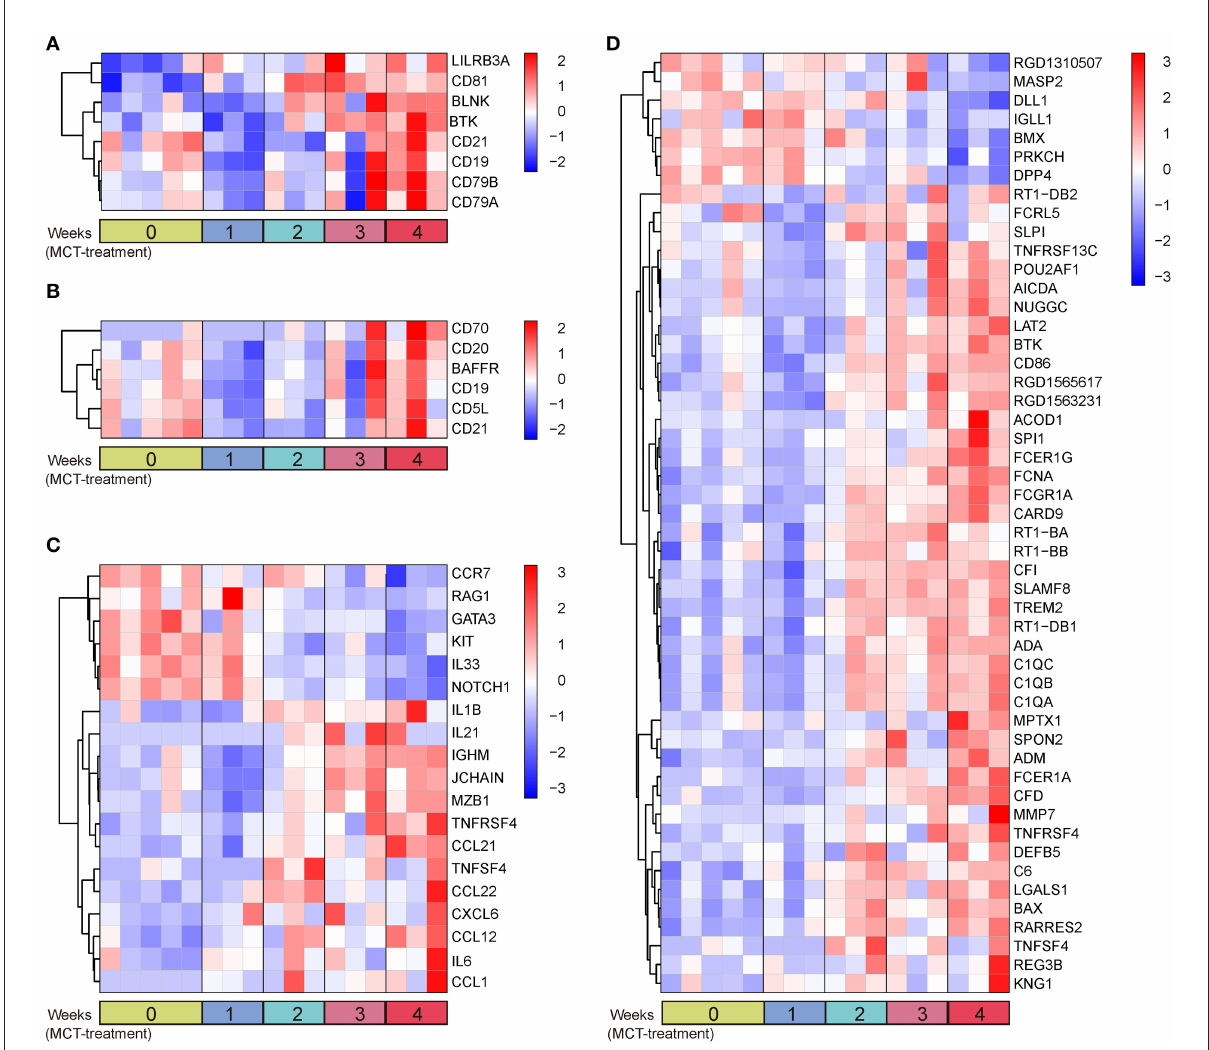
FIGURE5 Heatmap plot of humoral immune response-associated DEGs. (A) Eight overlapped DEGs in GO terms and BCR signaling pathway. (B) DEGs in B-cell homeostasis (GO:0001782), activation (GO:0042113), and proliferation (GO:0042100). (C) DEGs in immature B-cell differentiation (GO:0002327), immunoglobulin production (GO:0002377), and humoral immune response (GO:0006959). (D) DEGs in remaining unassorted terms associated with humoral immune response. Rows and columns represent gene expression levels and each sample, respectively. Red and blue represent the elevation and decrease of corresponding gene expression,